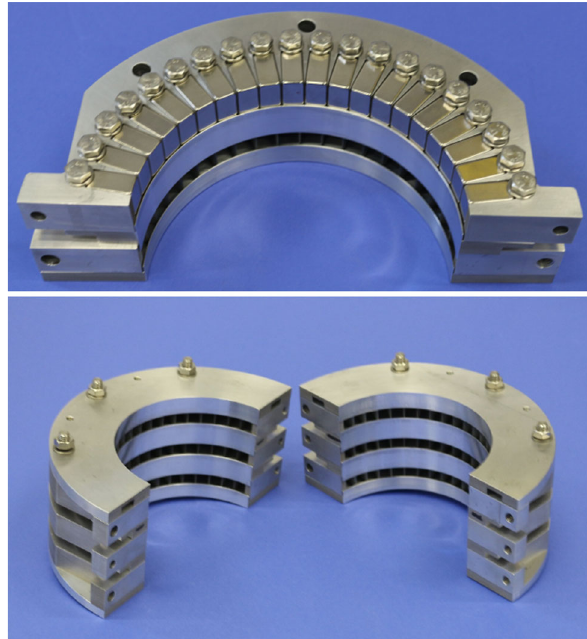
Fig. 9 Top: sequence of bar magnets for outer magnetic ring. Bottom: two halves of the complete outer magnetic ring